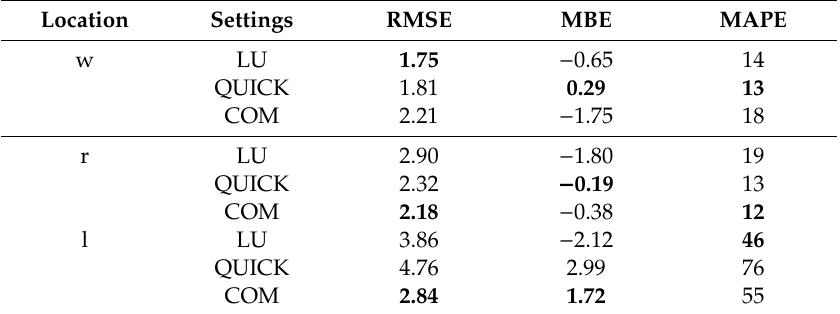
Table 9. Model root mean square error (RMSE), mean bias error (MBE), and mean absolute percent error (MAPE) for wind speeds at windward (w), ridgetop (r), and leeward (l) sensor locations for all sites. Positive MBE indicates model over-prediction. Bold font indicates the lowest error at each